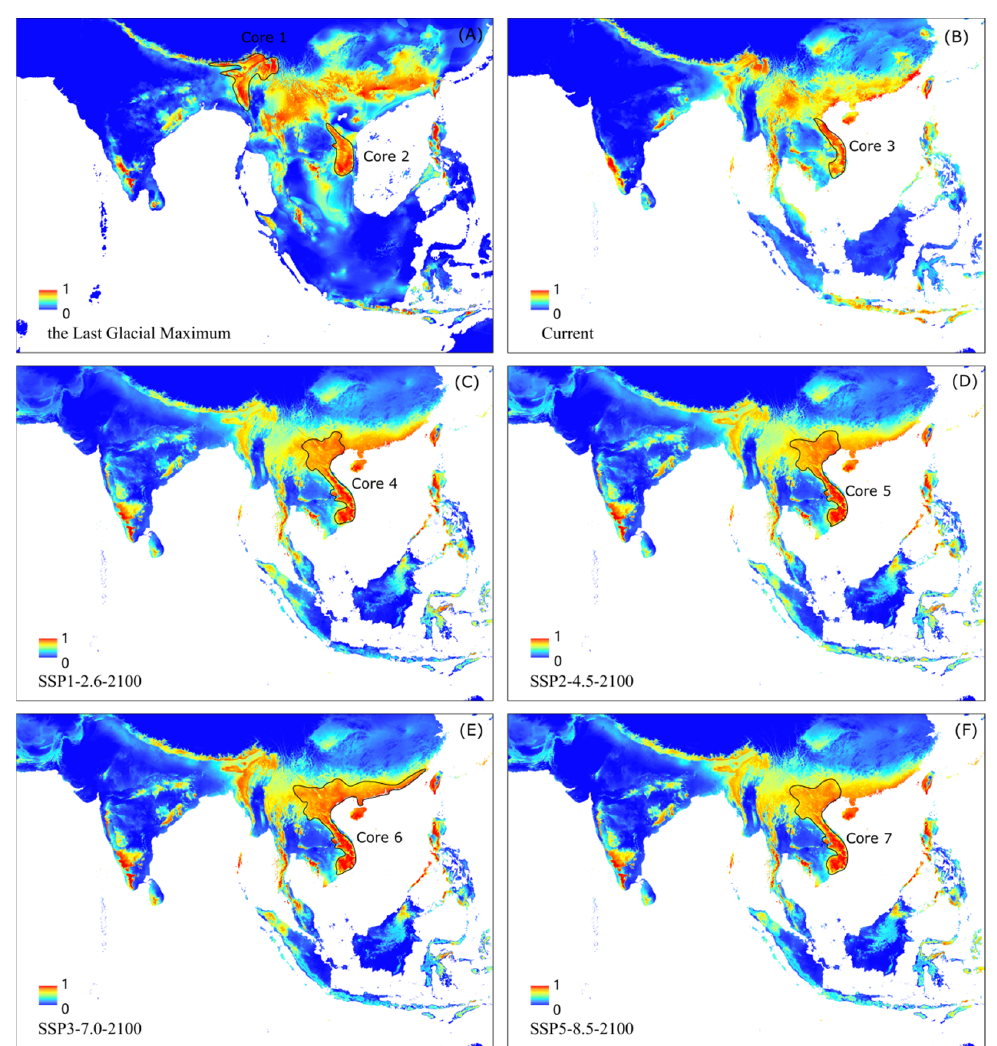
Figure 6. Prediction of core distribution areas under climate conditions: ( A ) historical climate; ( B ) current climate and future climate in 2100 under four scenarios, ( C ) SSP1-2.6, ( D ) SSP2-4.5, ( E ) SSP3-7.0, and ( F ) SSP5-8.5.